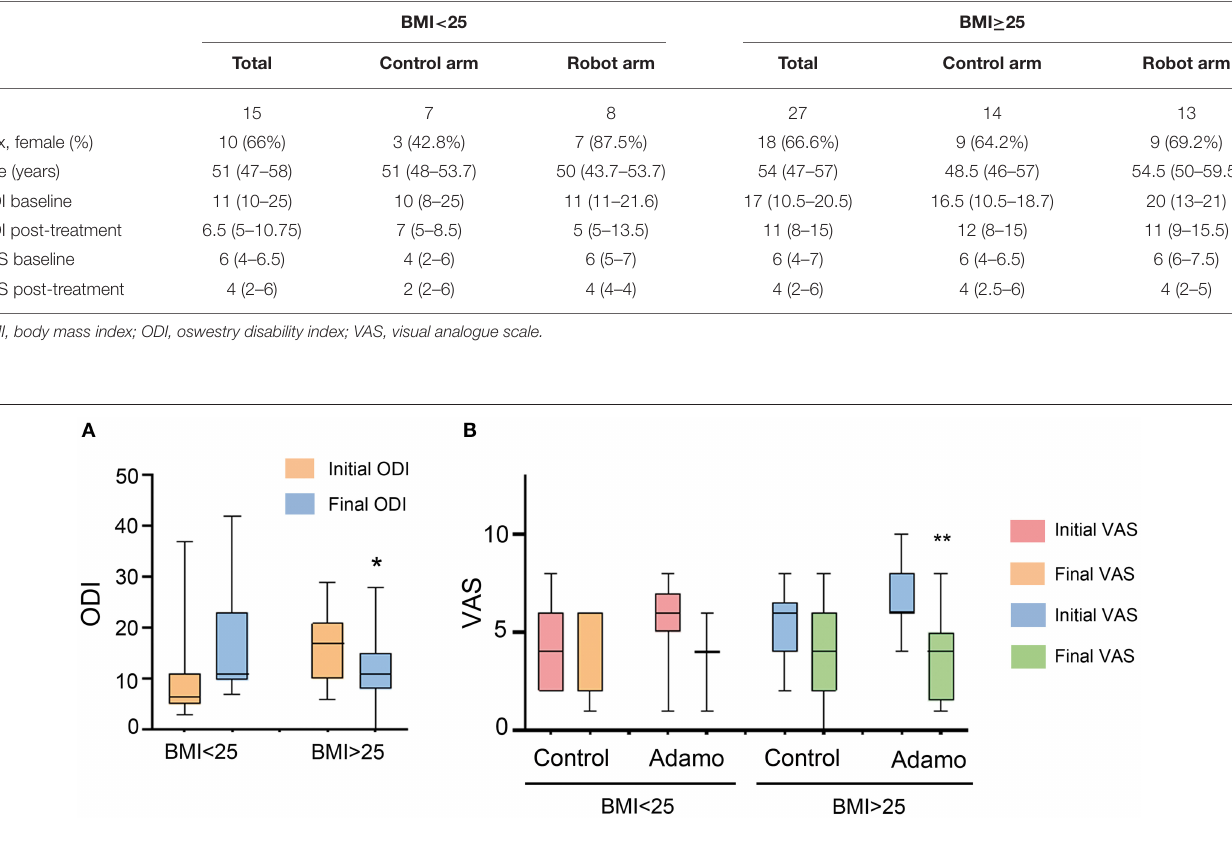
Frontiers in Neurorobotics |